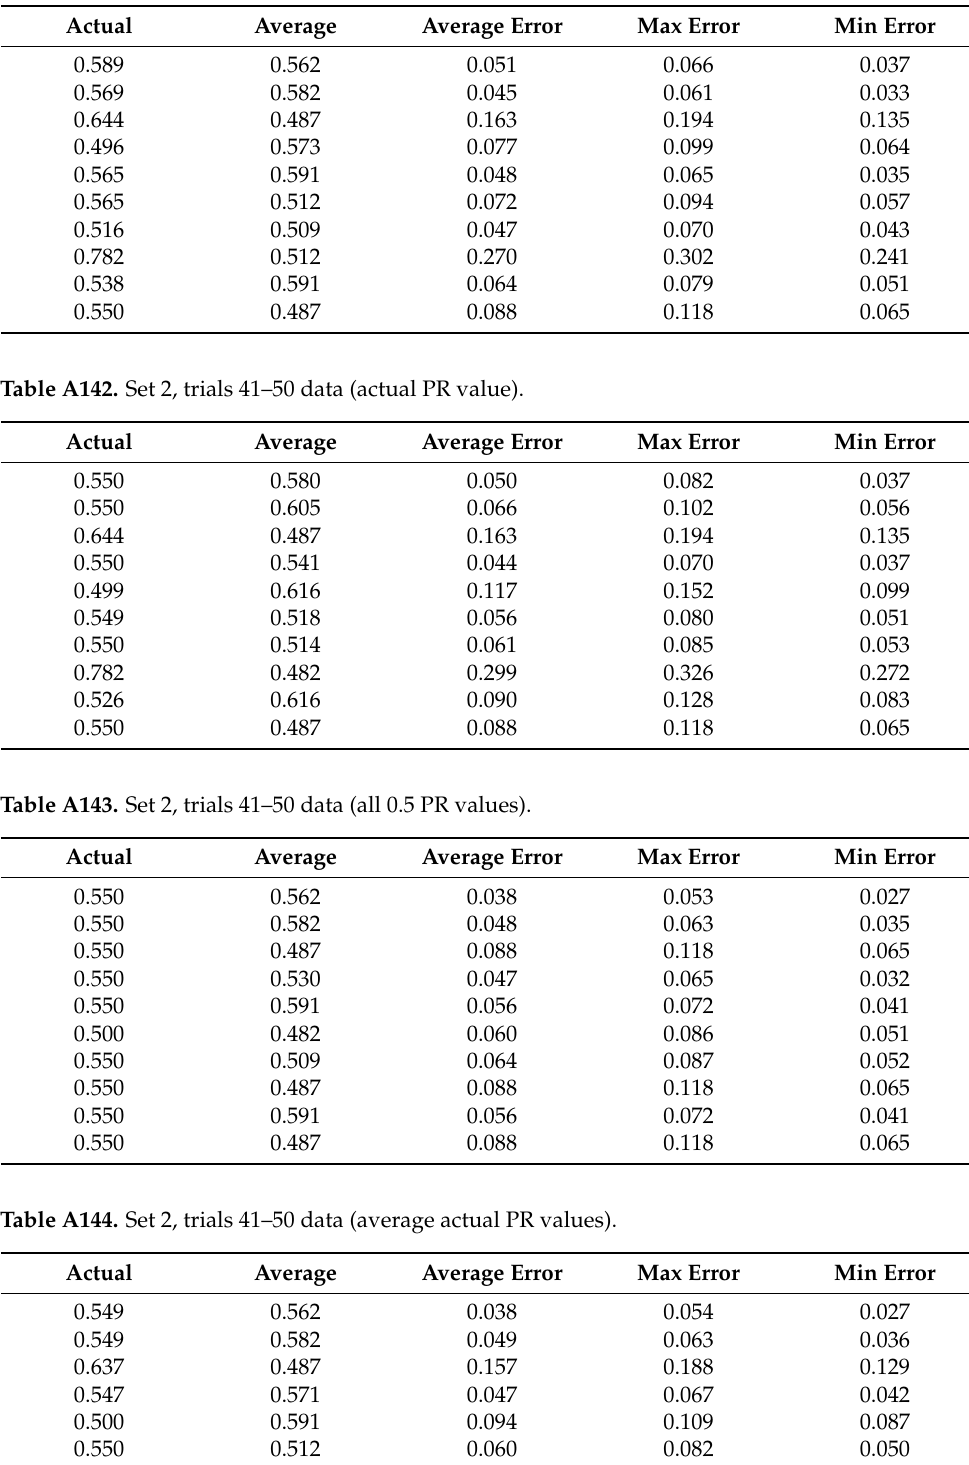
Table A141. Set 2, trials 41–50 data (single 0.5 PR value).